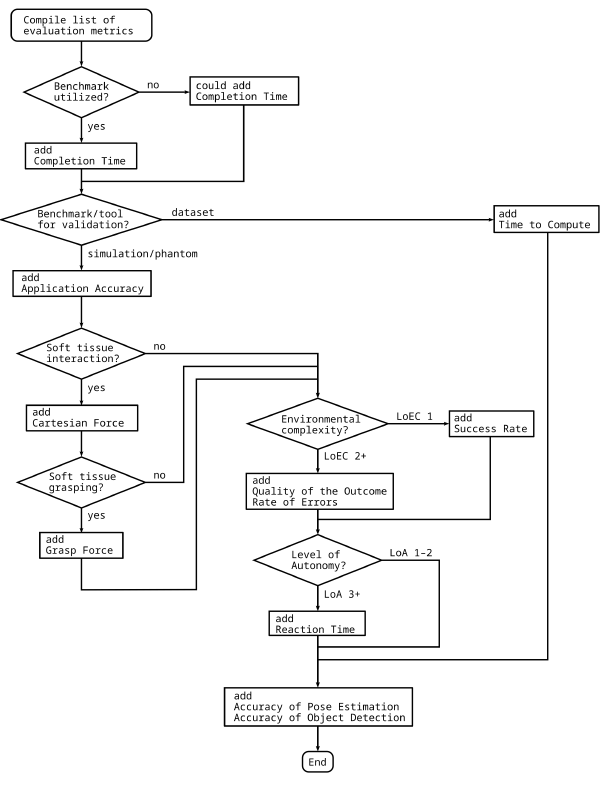
Figure 5. Flowchart to compile a list of performance metrics for the validation of different autonomous applications. The proposed method requires different properties of the autonomous surgical ap- plication, the task and the validation environment as input, and outputs the list of recommended validation